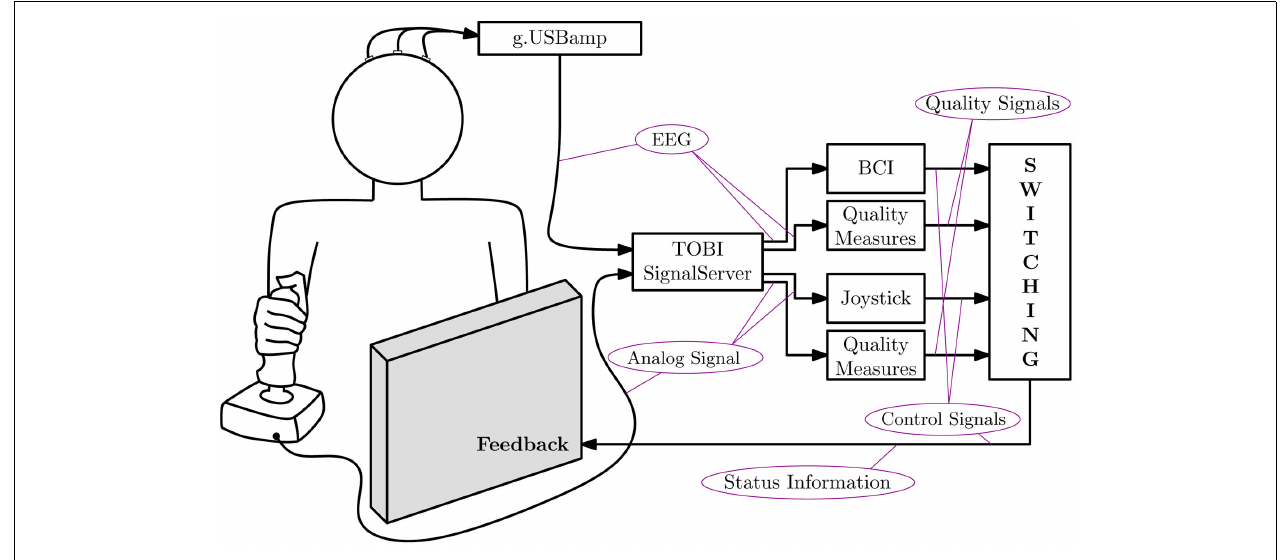
which chooses the input to use as a control signal.This control signal and information about the current state are passed on to the feedback, the car